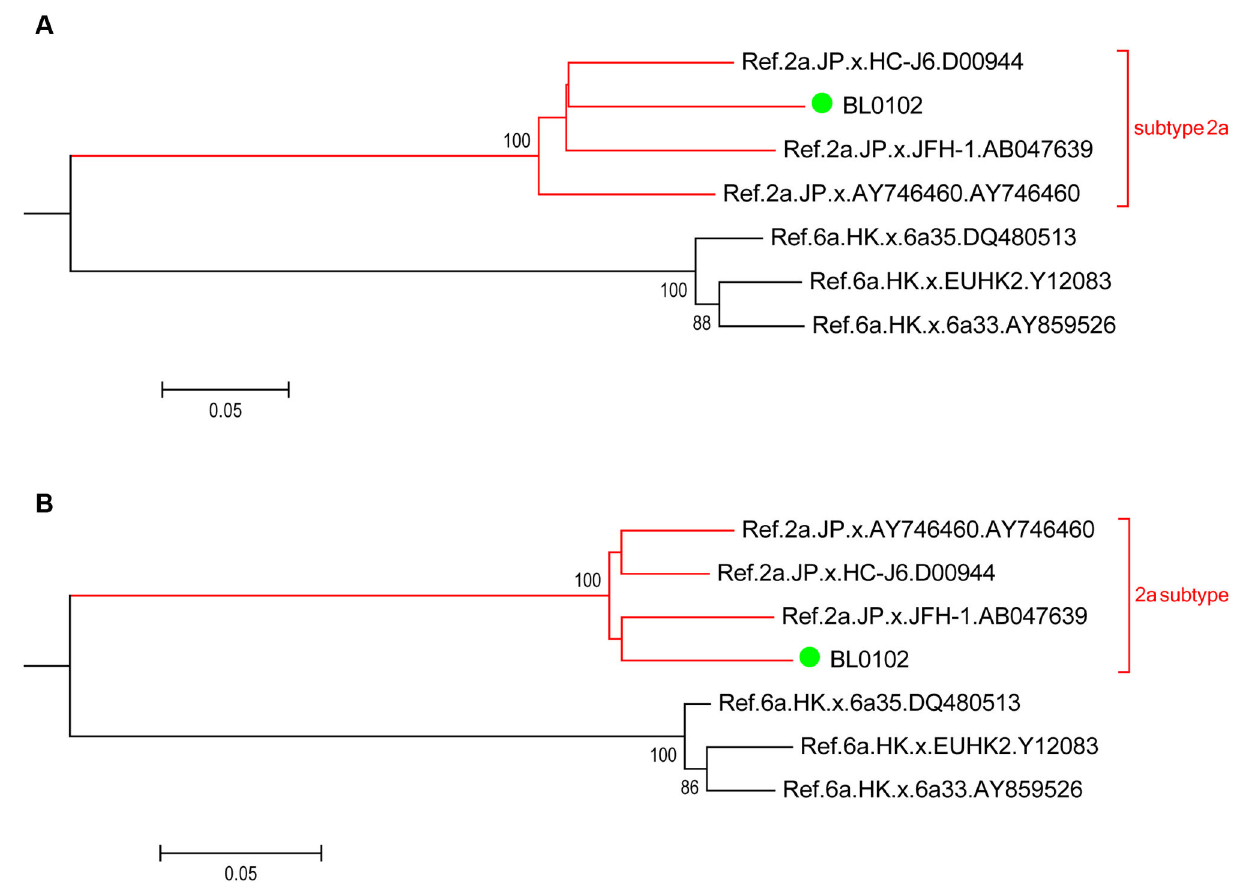
Figure 3. Subtype analysis of Heyuan HCV case BL0102. The Neighbor-joining phylogenetic trees were constructed based on the extended Core-E2 (A) and the NS5B (B) near full length fragments respectively. The BL0102 case was highlighted in green filled circle, subtype 2a branch was bracketed in red square. Bootstrap values are based on 1 000 replicates and statistic values > 70% are indicated at the nodes of the corresponding branches. The scale bar unit is